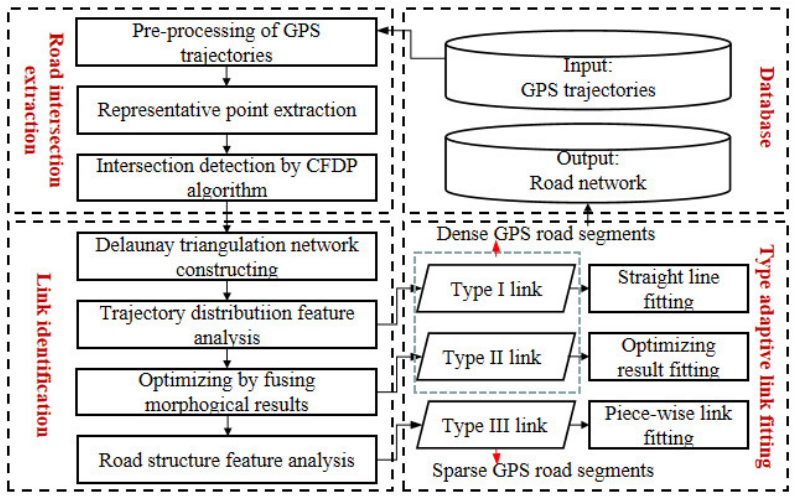
Figure 3. Workflow of road network construction for old downtown areas.